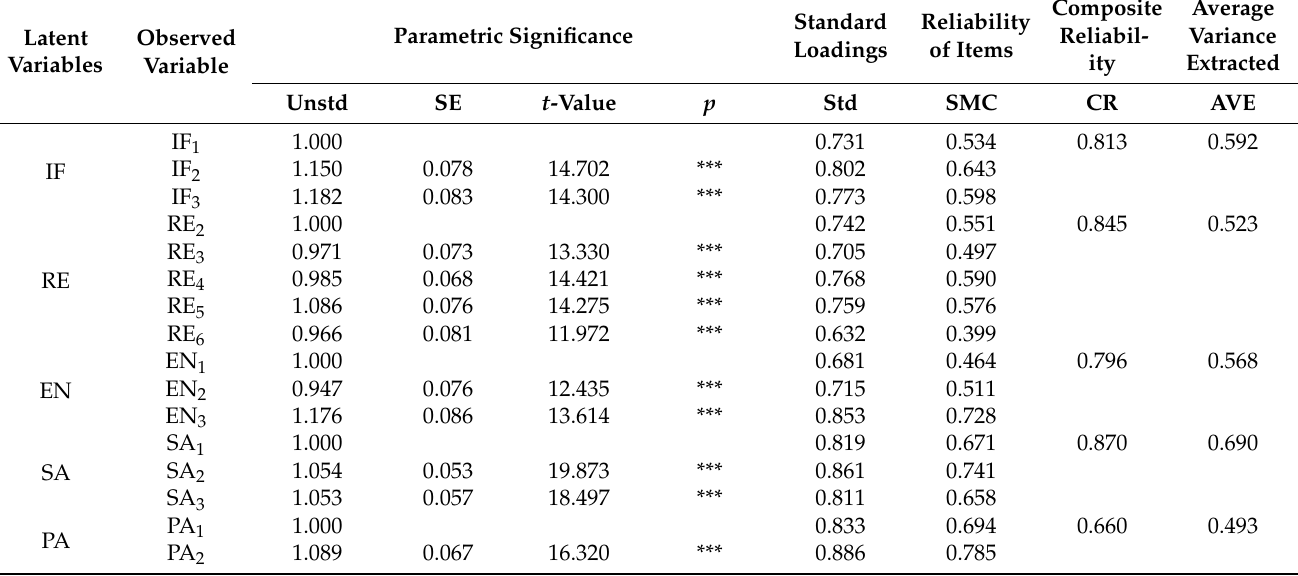
Table 5. Confirmatory factor analysis and validity